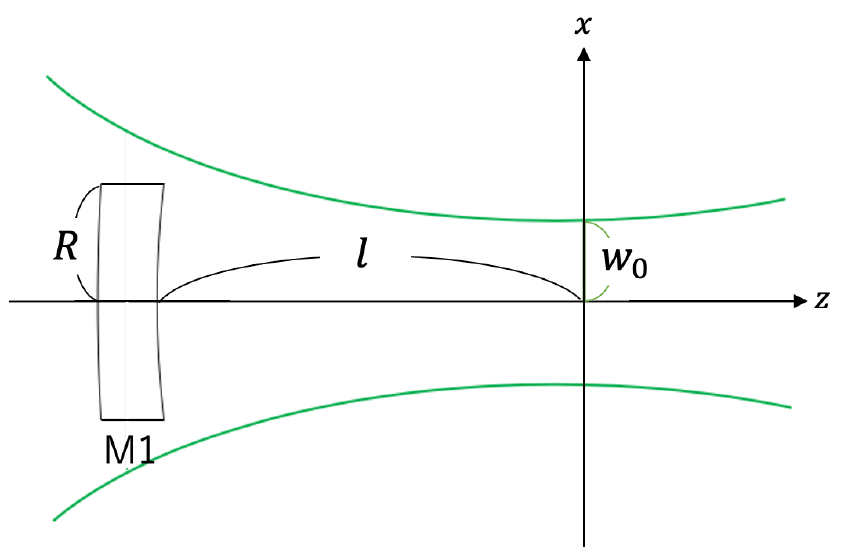
Figure 1. Illustration of the propagation of light with the wavelength of λ around the input mirror of a FP cavity. The input mirror with radius of R is labeled M1. The z axis is the laser beam axis, and the xy plane is perpendicular to the laser beam axis. The beam waist in the cavity is at z =